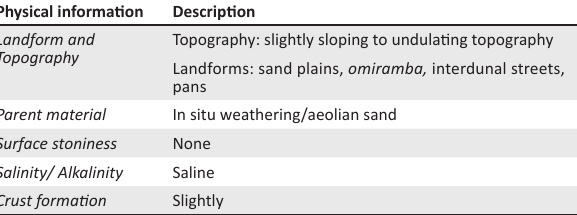
TABLE A1.8a: Typical characteristics of the petric Calcisols.